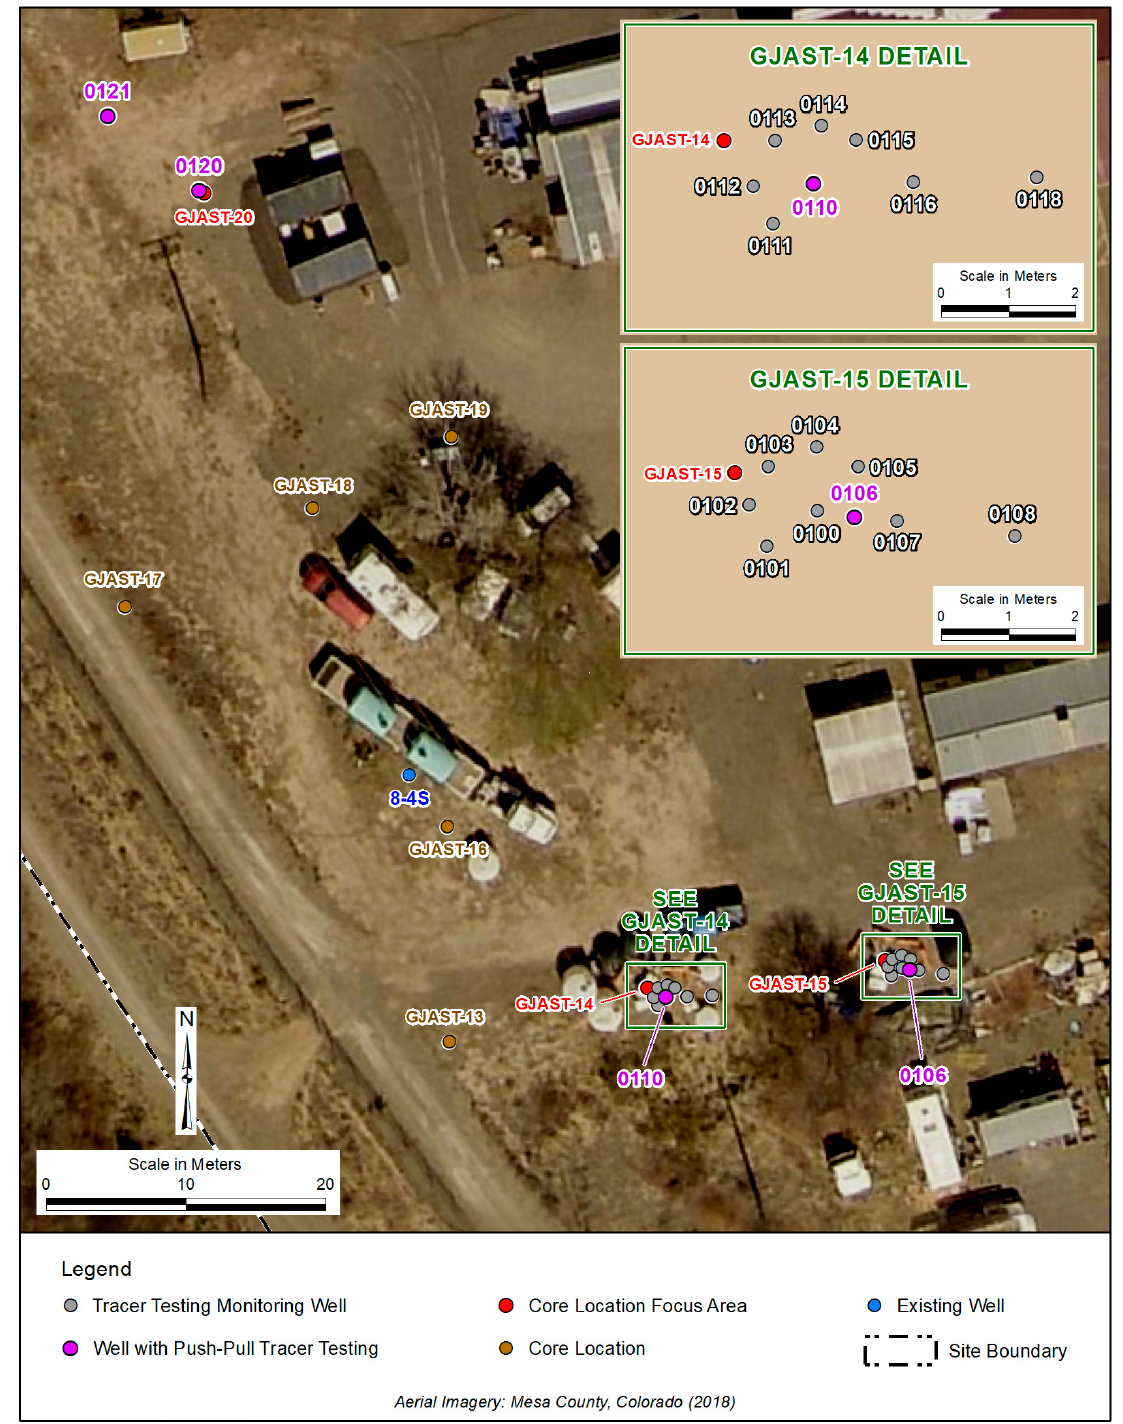
Figure 2. GJO site around focus areas with wells installed for tracer testing. The four single-well push–pull tracer testing wells (0106, 0110, 0120, and 0121) are highlighted purple, and all other wells were used for monitoring only. Figure modified from Johnson et al.